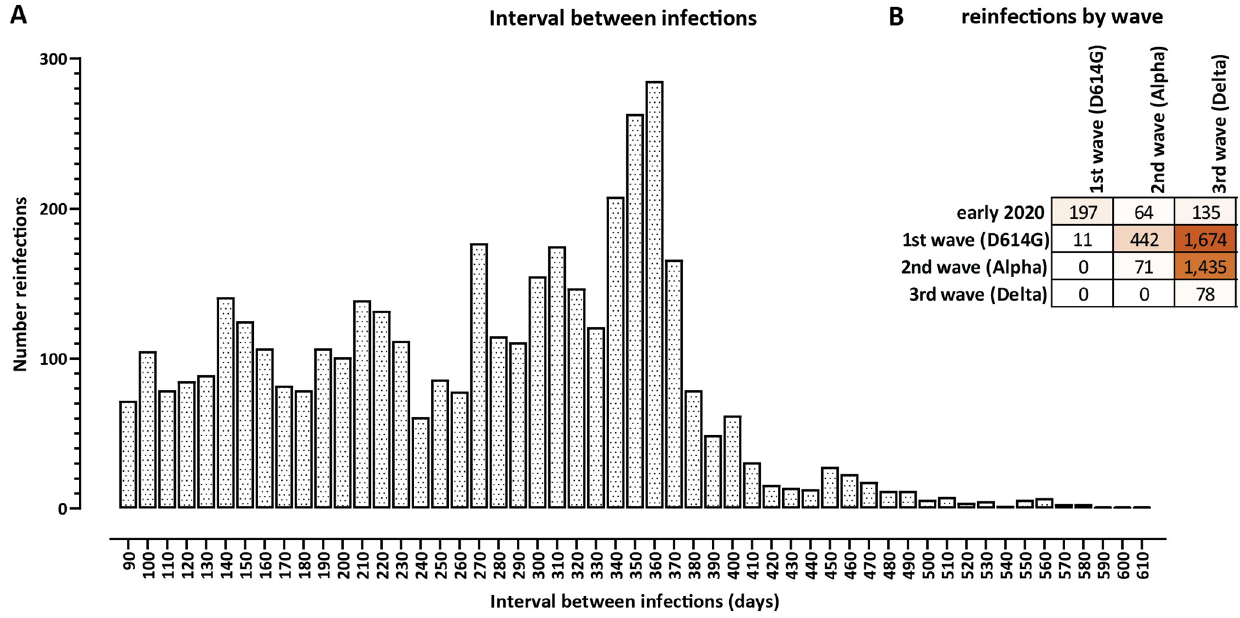
Fig 2. Time between primary infections and reinfections against the background of different SARS-CoV-2 variants. (A) Distribution of the length of the interval between primary infection and reinfection. (B) Primary infections and reinfections by wave and dominant variant. Waves were defined as follows: “initial infections” refers to the period prior to September 2020; “1st wave” refers to the period between September 2020 and the middle of January 2020, during which D614G variants without many other notable mutations were dominant; the “2nd wave”, between mid-January 2021 and June 2021 was dominated by the B.1.1.7/Alpha variant; the “3rd wave”, dominated by the B.1.617.2/Delta variant, began in July 2021.